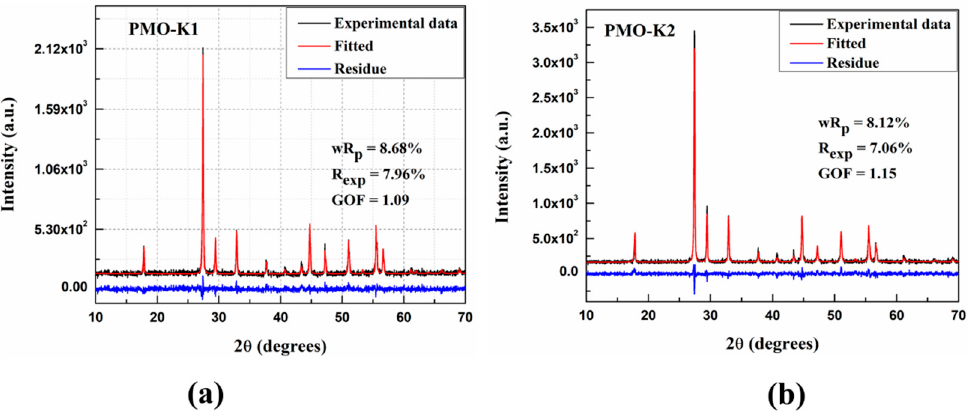
Figure 4. XRD patterns of ( a ) PMO-K1 and ( b ) PMO-K2 crystals.